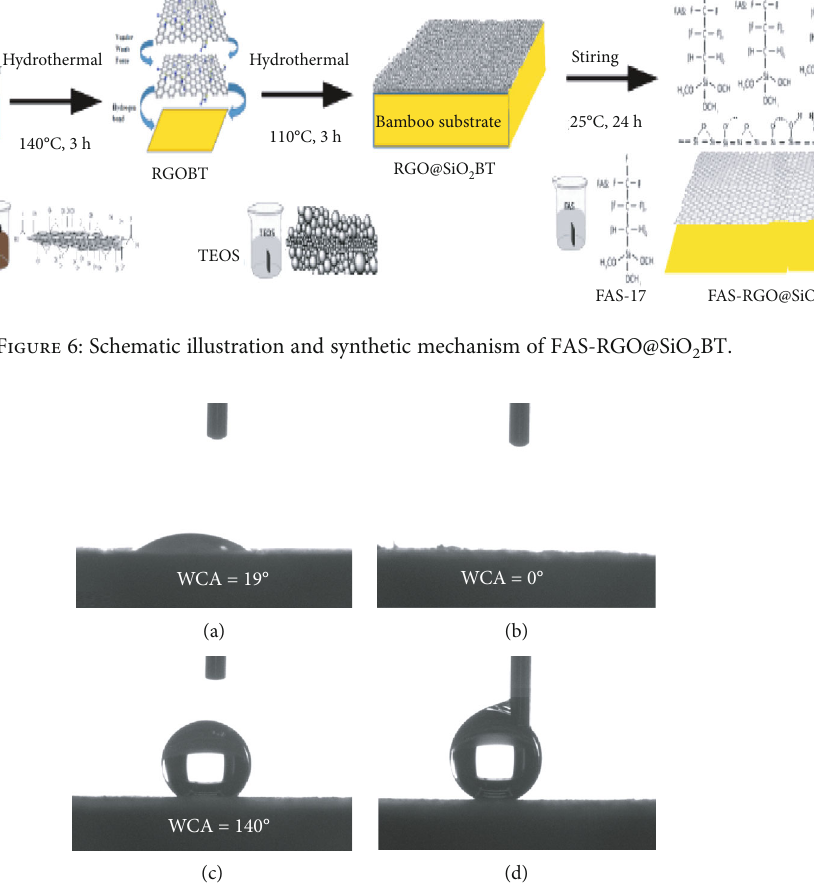
BT, and (d) FAS-RGO@SiO 2